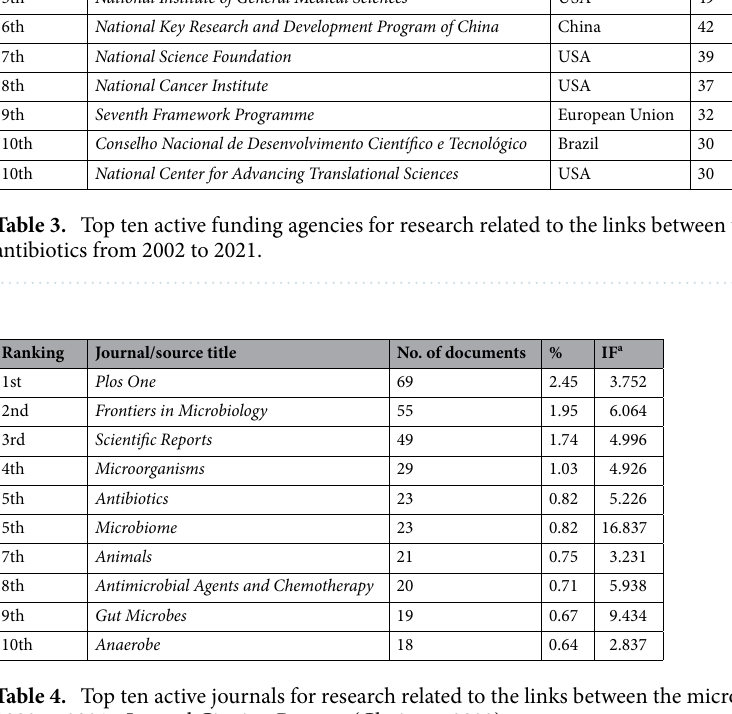
Table 4. Top ten active journals for research related to the links between the microbiota and antibiotics from 2002 to 2021. a Journal Citation Reports (Clarivate, 2022).